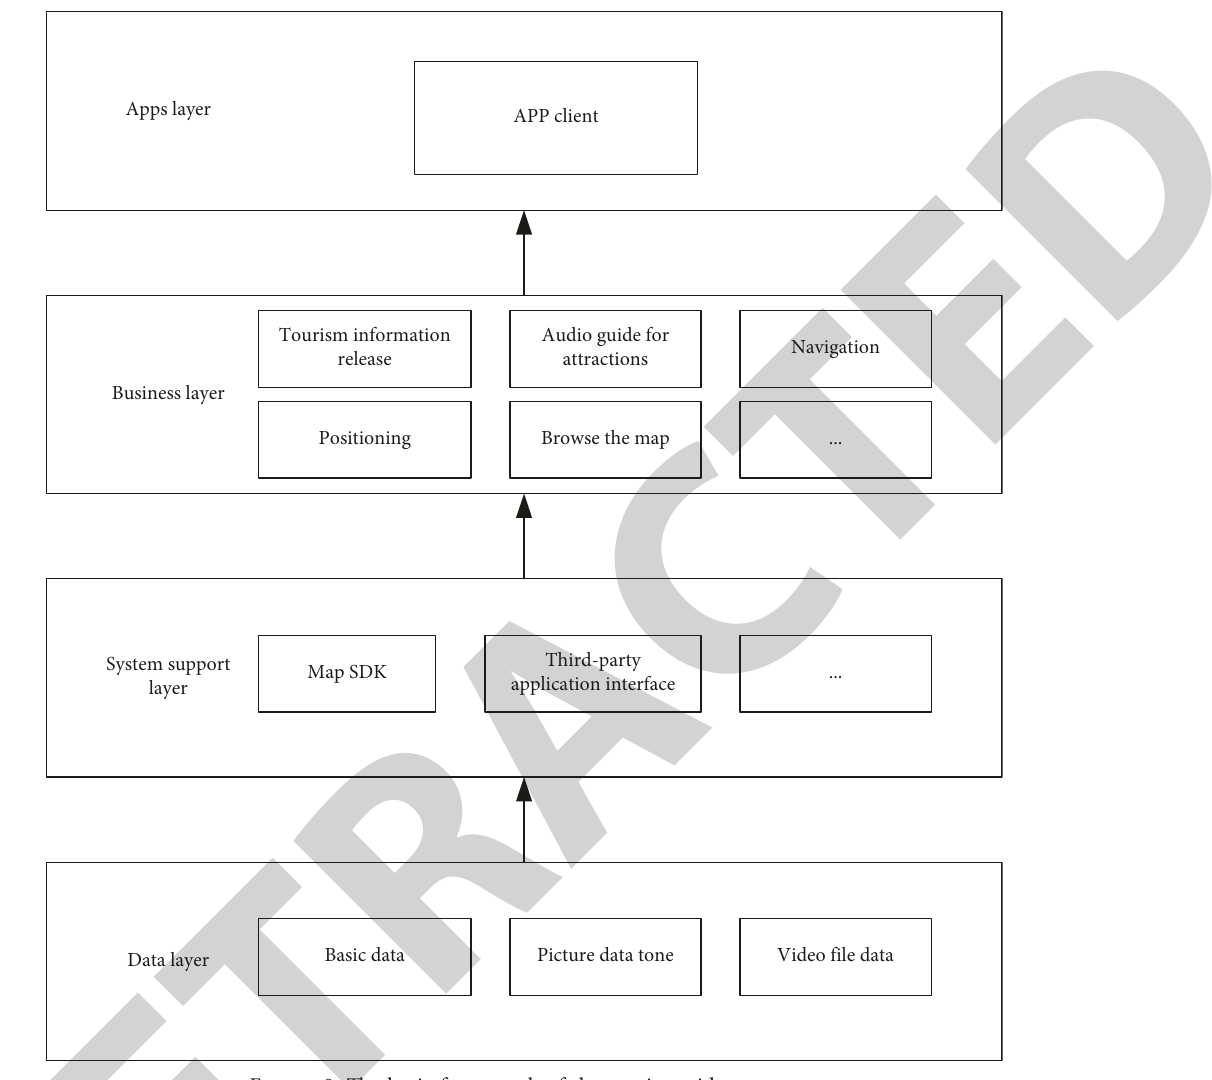
Figure 8: The basic framework of the tourist guide